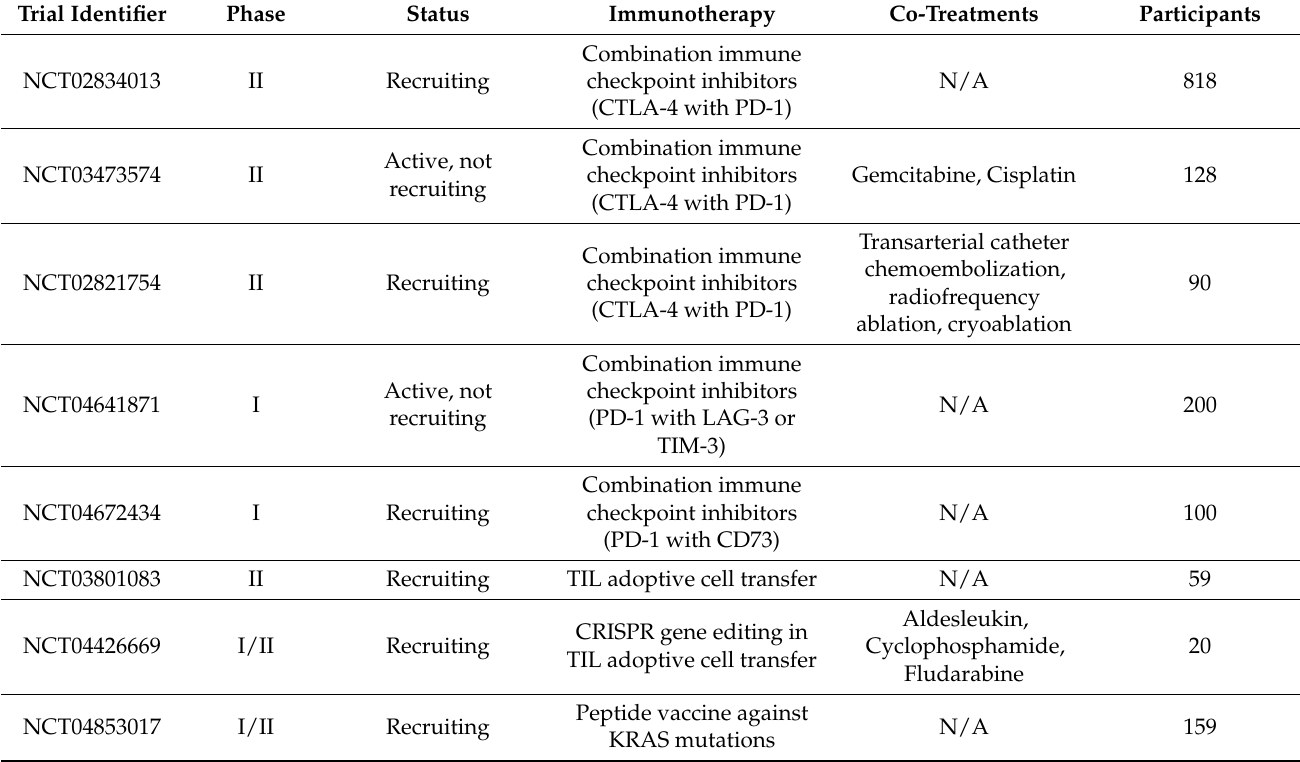
Table 3. Clinical trials currently evaluating immunotherapies in GBC. List of clinical trials involving combination immune checkpoint inhibitors, adoptive cell transfer, and other innovative immunotherapies in GBC. Source: clinicaltrials.gov (28 July 2021). GBC, gallbladder carcinoma; TIL, tumor-infiltrating lymphocyte; CRISPR, clustered regularly interspaced short palindromic